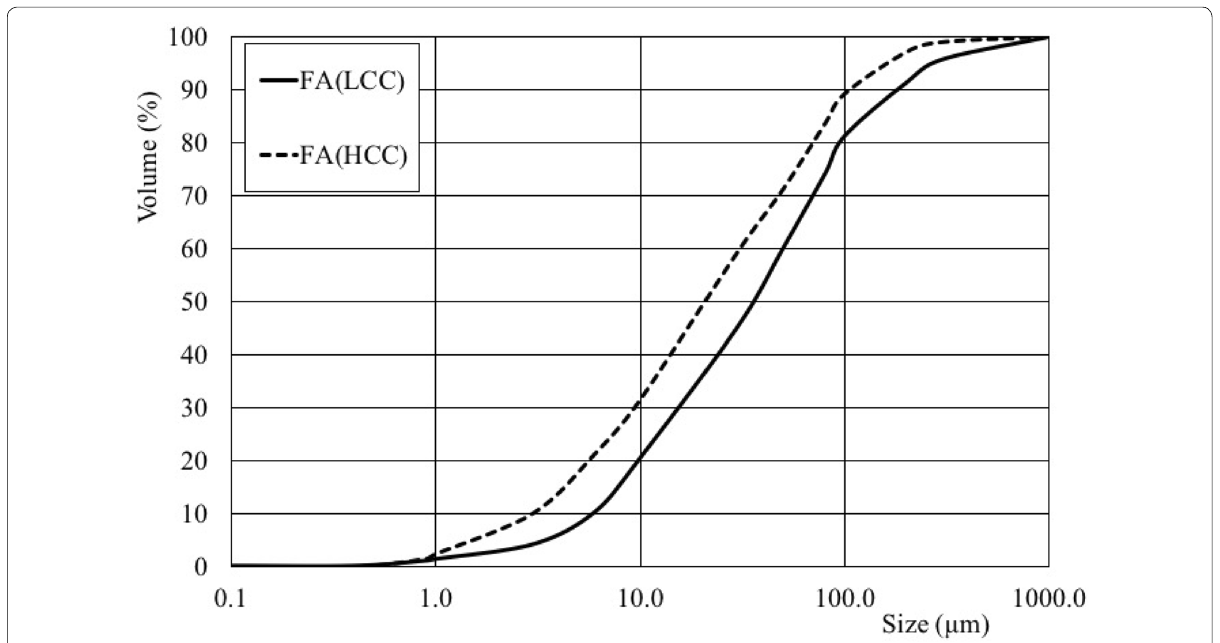
Fig. 1 Size distribution of the investigated fly ashes.